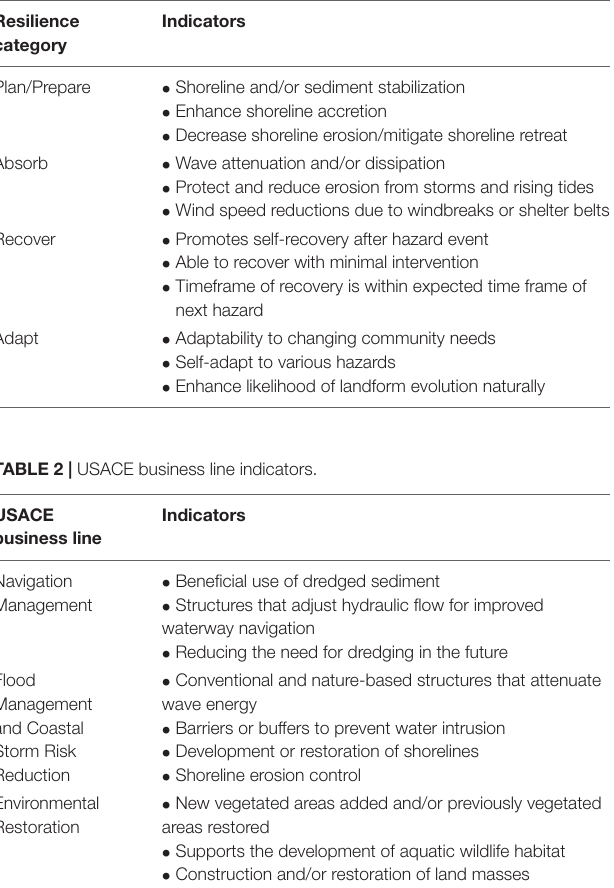
TABLE 1 | Resilience Indicators [adapted from Cunniff and Schwartz (2015)].